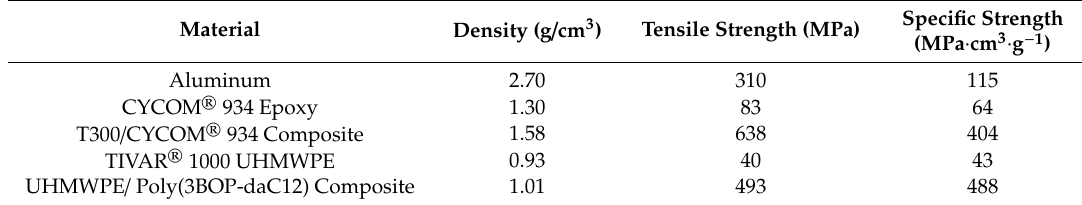
Table 6. Calculated specific strength values and properties used in specific strength